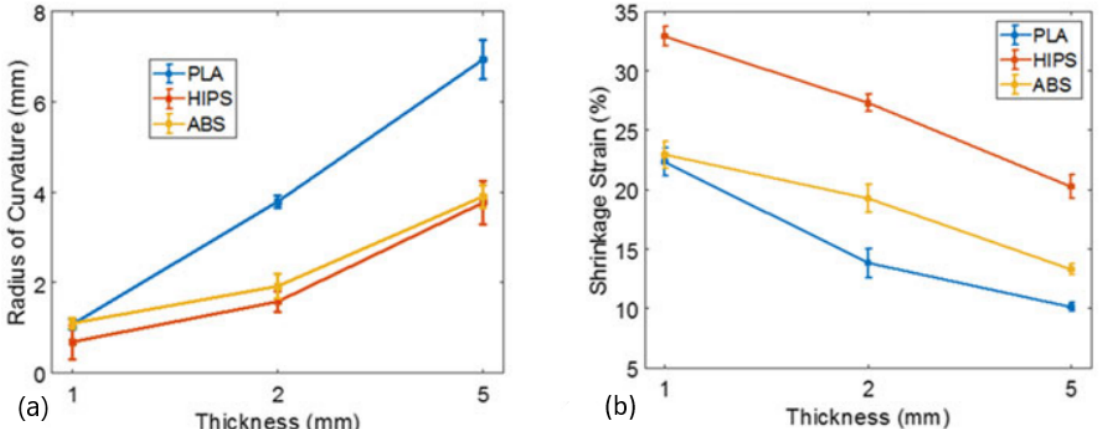
Figure 4. Effect of thickness on the: ( a ) radius of curvature; ( b ) shrinkage strain [48]. Material from: Rajkumar, A.R.; Shanmugam, K, Additive manufacturing-enabled shape transformations via FFF 4D printing, published (2018) (Springer Nature) reproduced with permission of